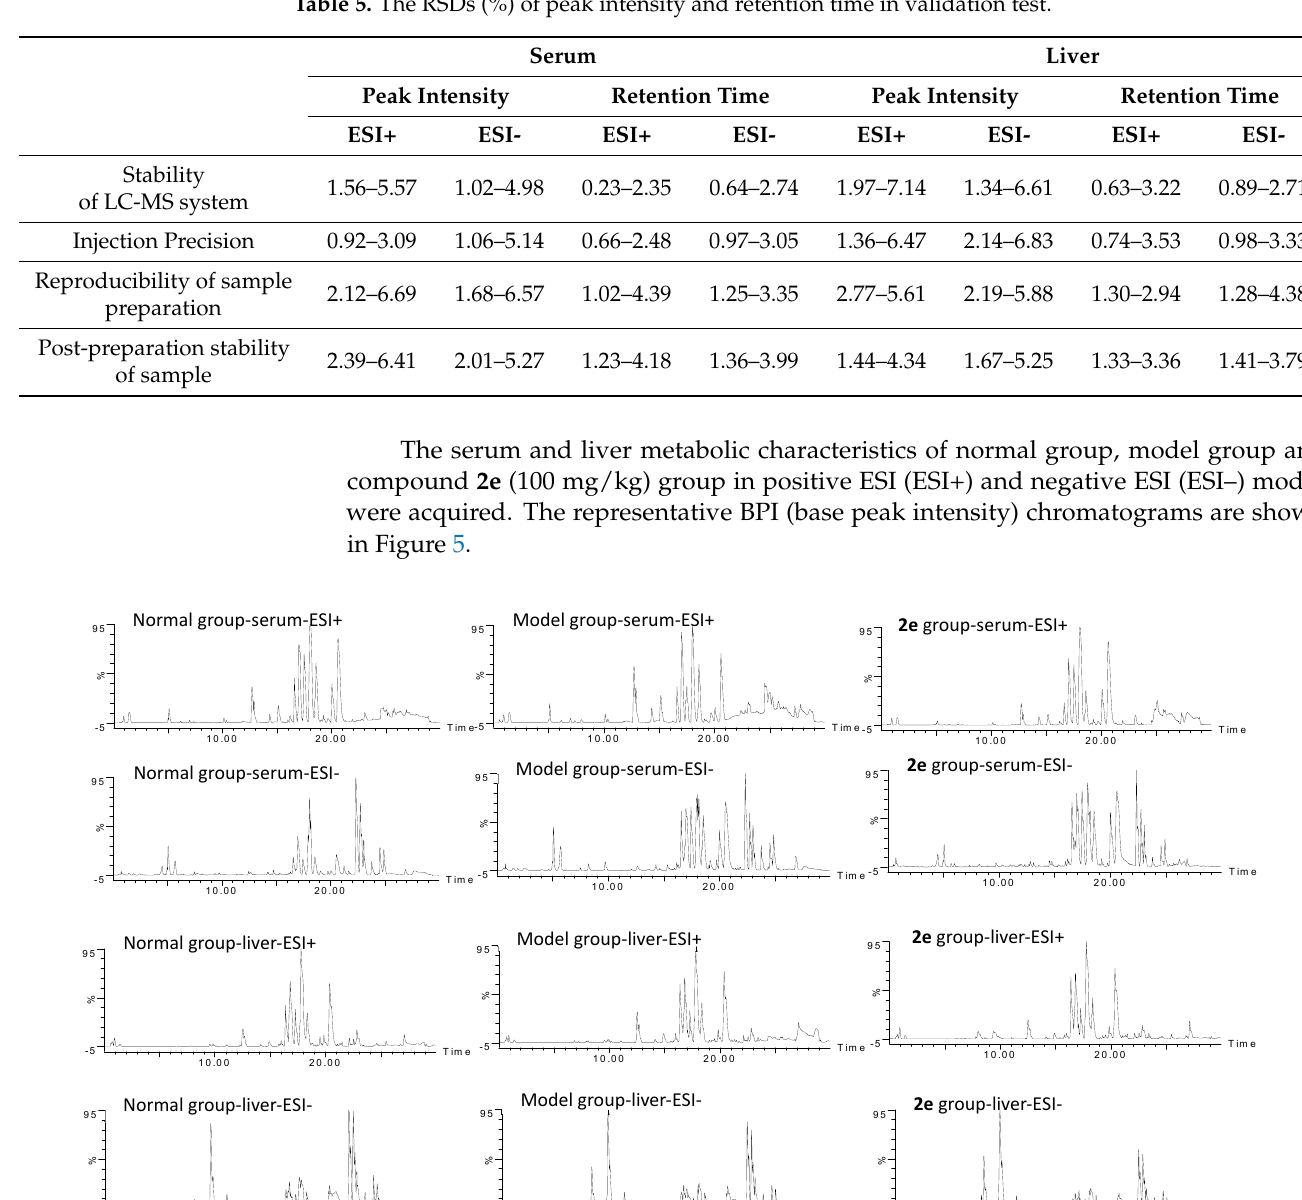
Figure 8. The predictive receiver operating characteristic (ROC) curves generated using 21 biomarkers contributing to ( A ) liver ‐ tumor progress between model group and normal group, ( B ) compound 2e treatment between model group and compound 2e group.